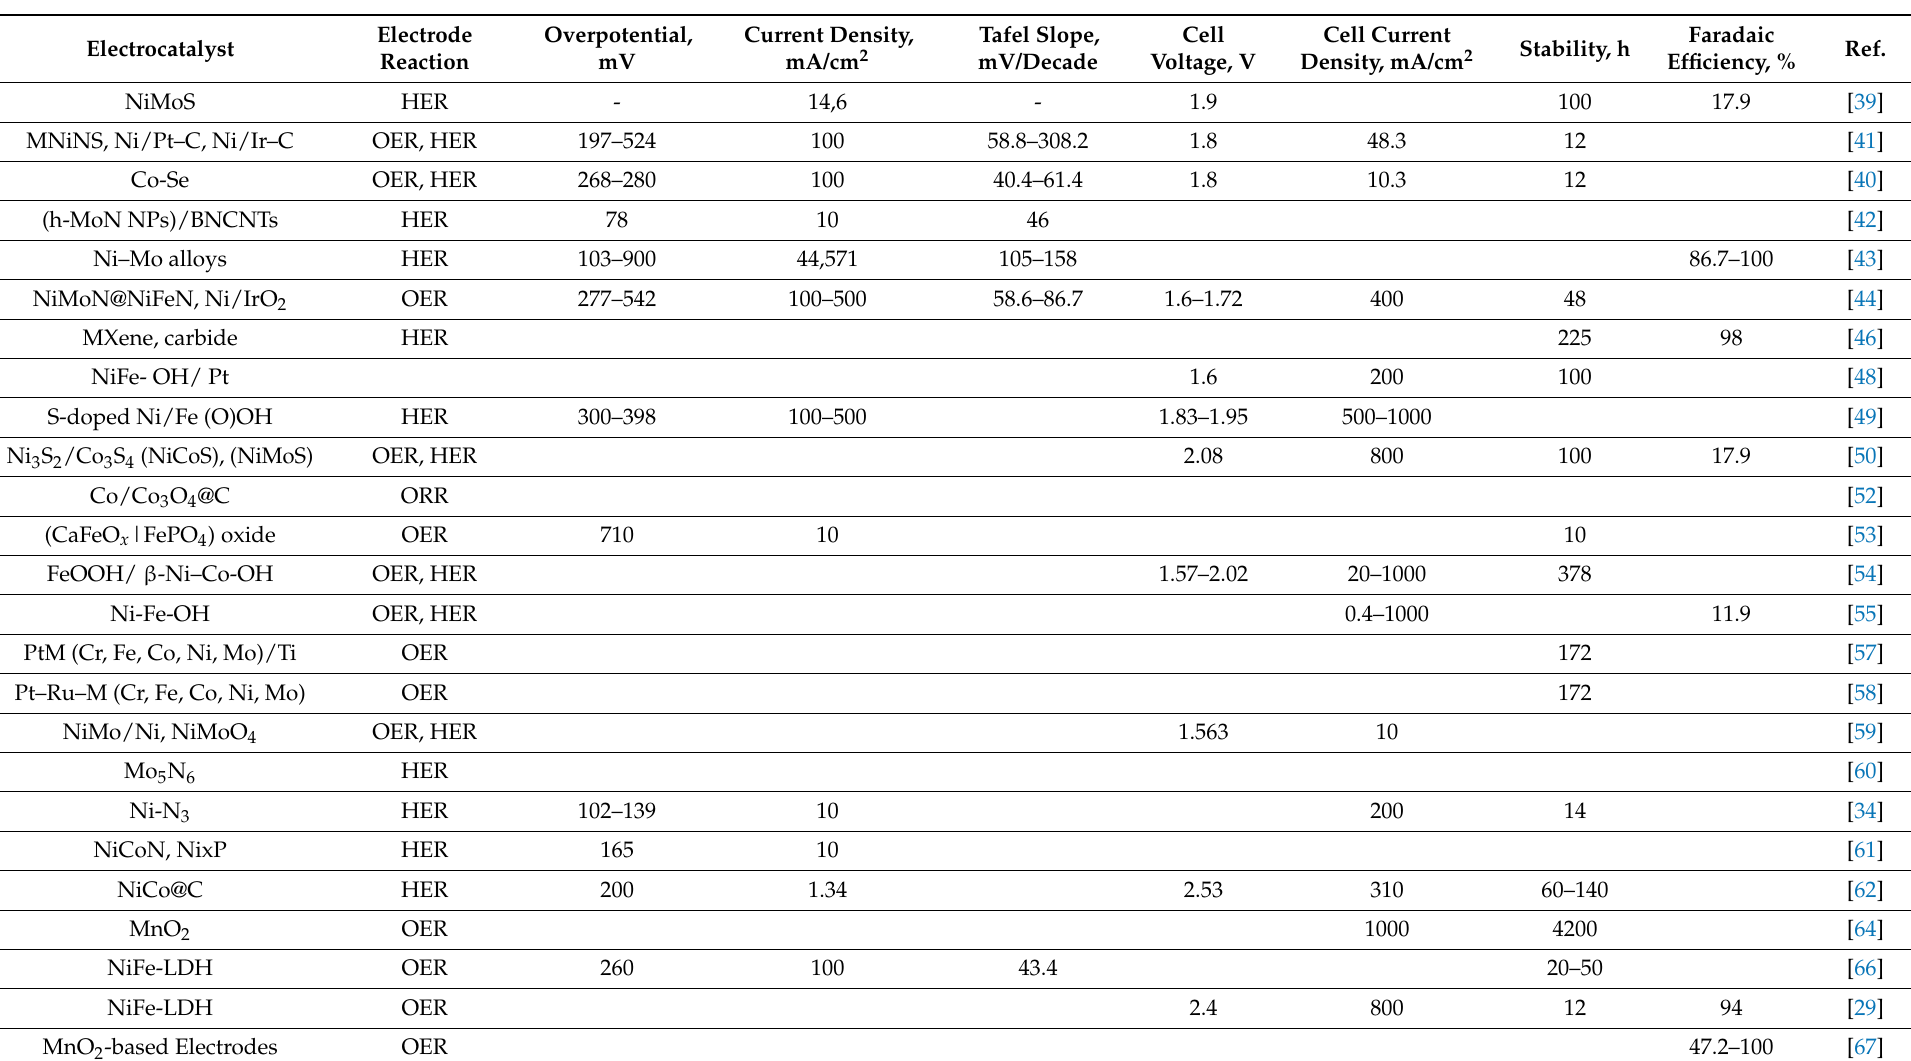
Table 4. Electrochemical parameters of some electrocatalyst and electrolyzers performance in seawater mentioned in studies published during the period 2018–2022.